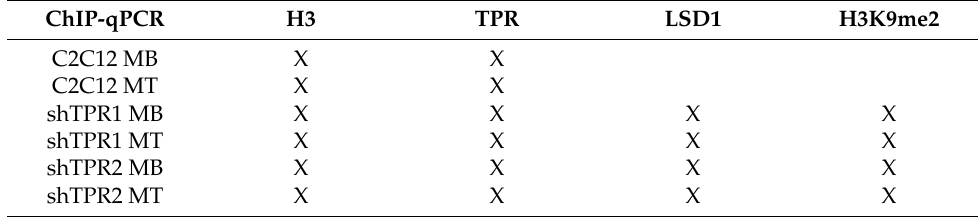
Table 3. Combination of the samples and antibodies for